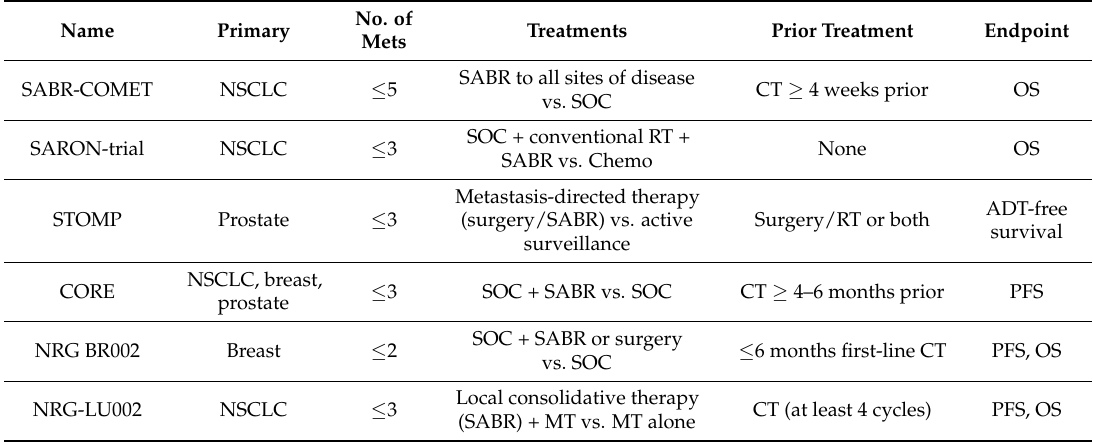
Table 1. Selected open trials of SABR for